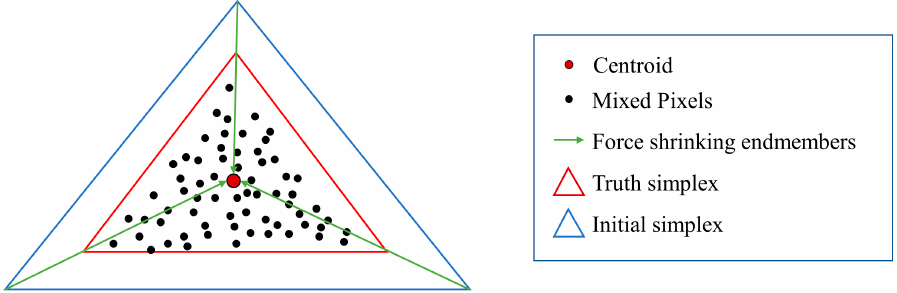
Figure 5. Geometric interpretation of minimum volume regularization. Each vertex of the simplex is considered as an endmember, and the initial endmembers are oriented toward the centroid of the simplex determined by the real endmembers.